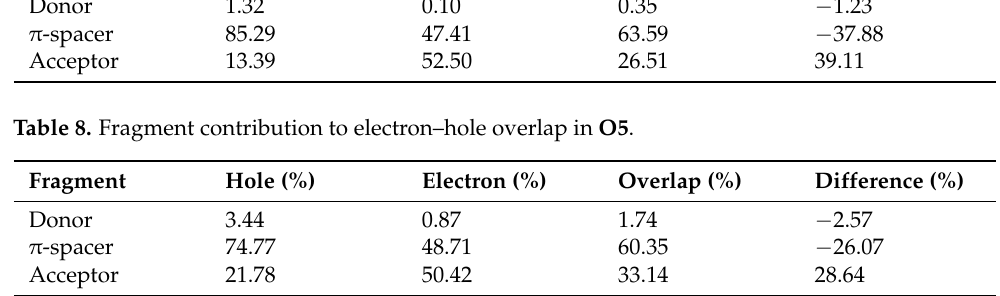
Table 9. Fragment contribution to electron–hole overlap in O6 .